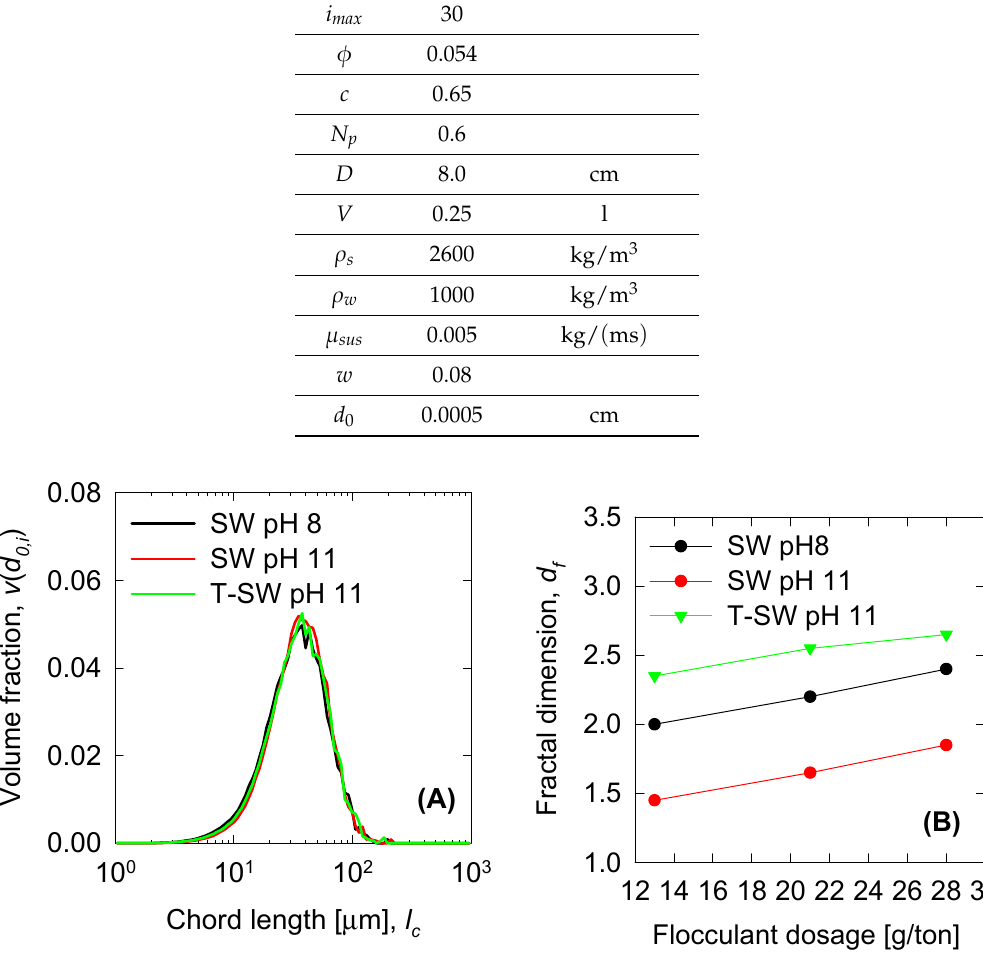
Figure 3. ( A ) Normalized initial volume distribution of particles of synthetic tailings in seawater at a mixing rate of 150 rpm. ( B ) Fractal dimension from the settling experiments. Table 1. Input parameters and conditions.